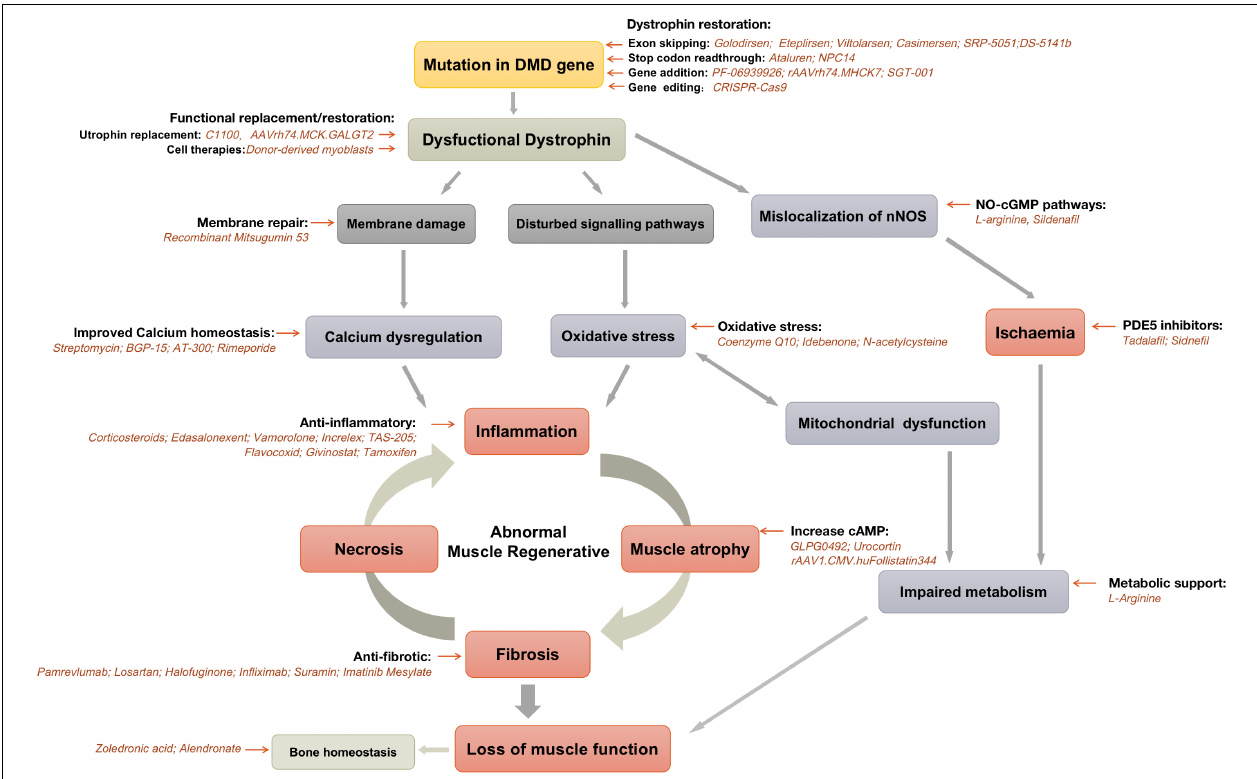
FIGURE 1 | Current pharmacological strategies for Duchenne muscular